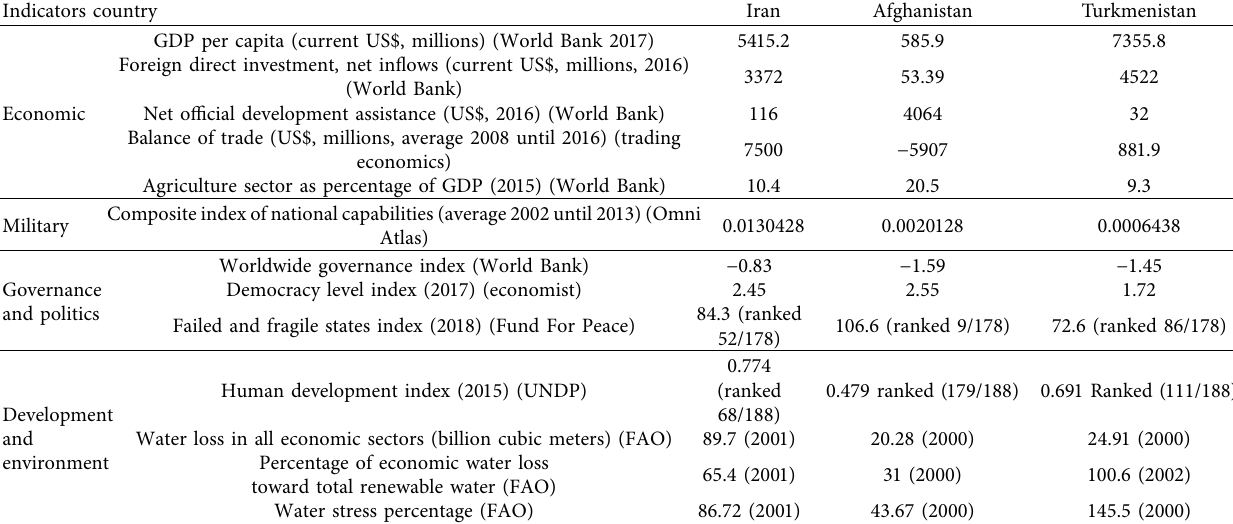
Table 1: Power indicators of the countries involved in the Harirud